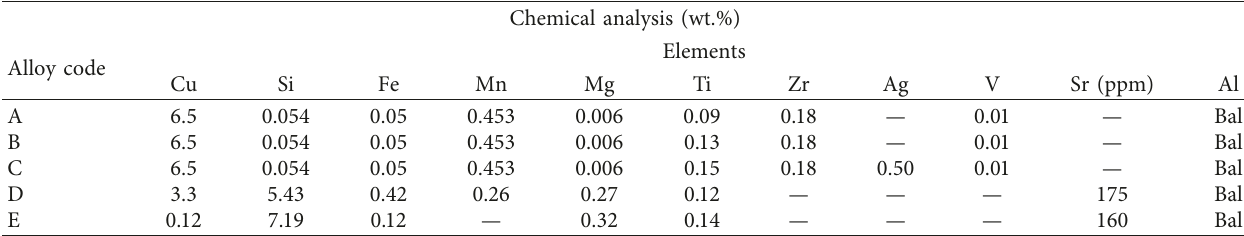
Table 2: Chemical composition of the HT200 alloys used in this